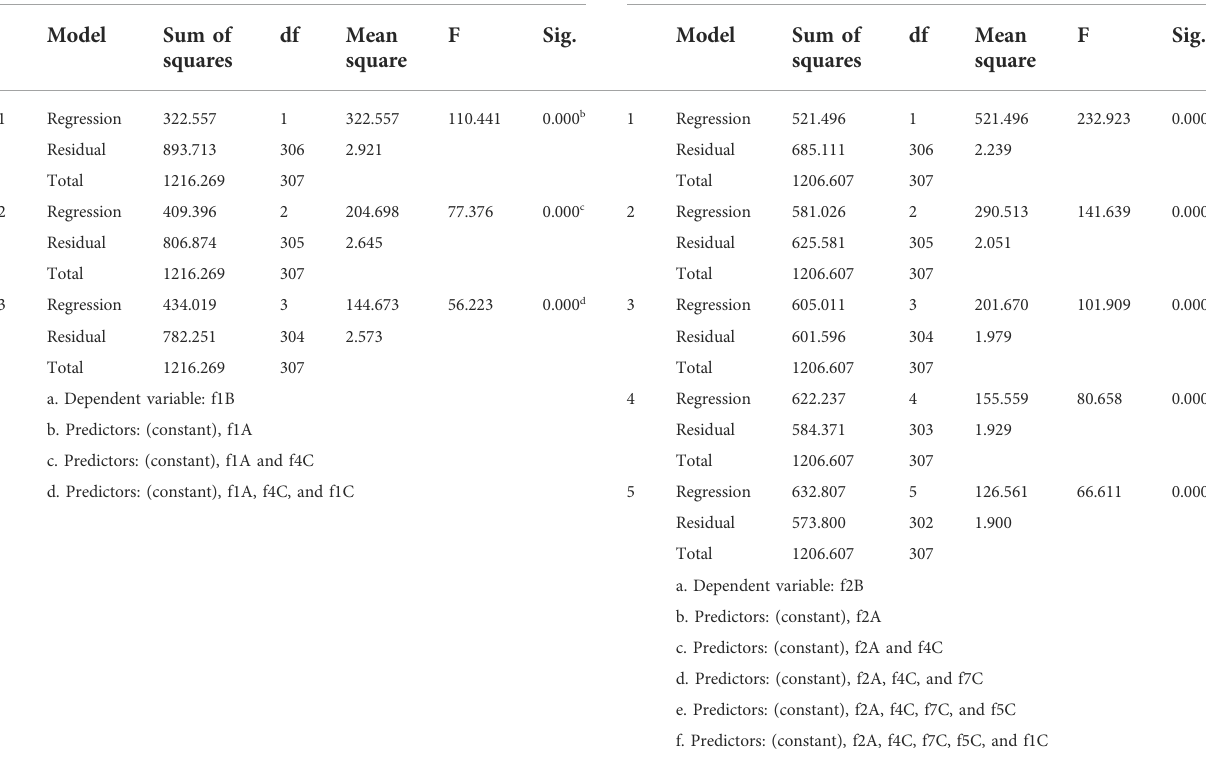
TABLE 4 ANOVA data regression analysis for both dependent